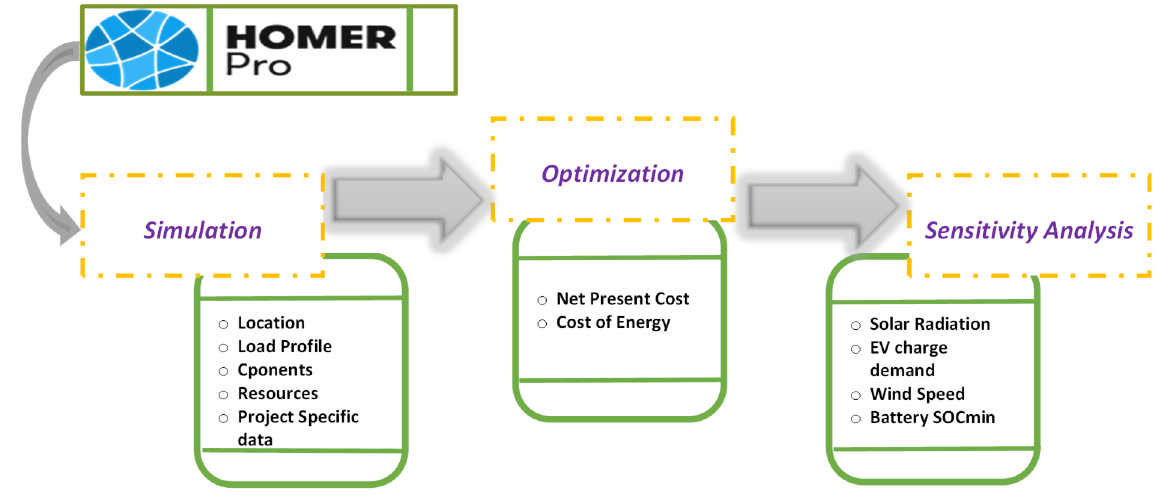
Figure 1. The evaluation process of the hybrid RE-based charging stations in HOMER Pro ® . Table 2. Hybrid renewable energy-based system models that were studied in different parts of the world with the aid of the HOMER simulation tool. Country Simulation Tool/ Year Parameters